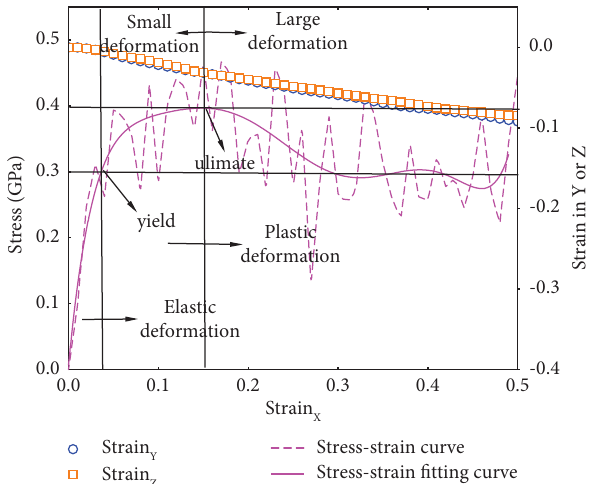
Figure 5: Stress-strain behavior of the model amorphous cellulose deformed in the X -direction at strain rate 10 − 4 /ps, and the cor- responding strain in the Y -direction and the Z -direction. Te yield, ultimate points, and the various deformation regimes are